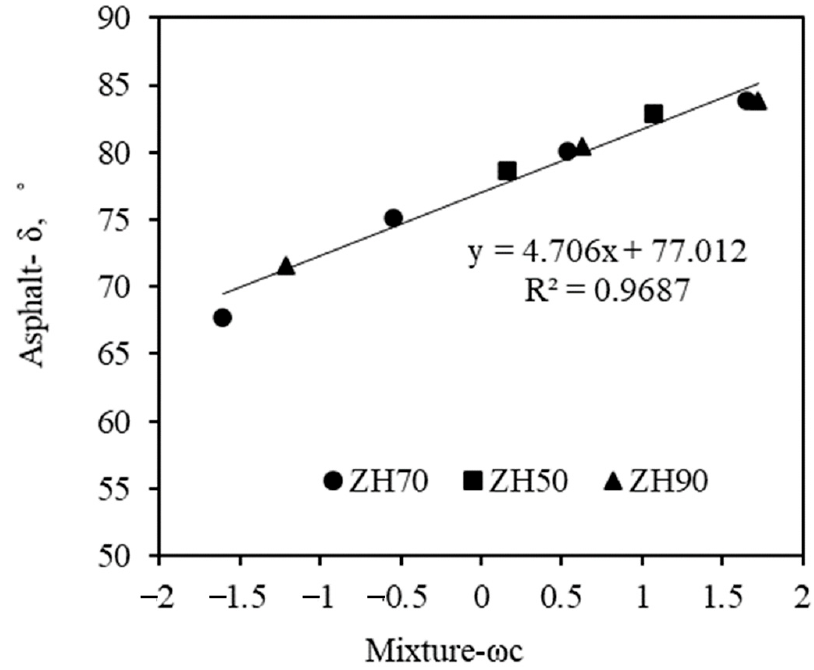
Figure 9. Relationship between ω c and asphalt phase angle. In the theory of polymer physics, the ω c position is related to the relaxation character- istics of polymer materials, which is defined as the relaxation peak [10]. Its significance is to characterize the response ability of the viscoelasticity of materials under external action. Only when the load time (t) is close to the material relaxation time ( τ ), that is, the action frequency ( ω r ) is the same as the reciprocal of the relaxation time ( τ − 1 ) ( ω r = τ − 1 ), is the energy consumption of the material the highest, which reflects the peak value of the